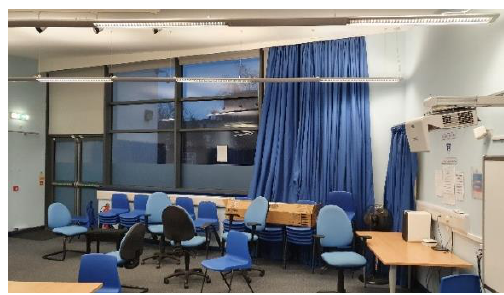
Figure 15. Picture of classroom D3.